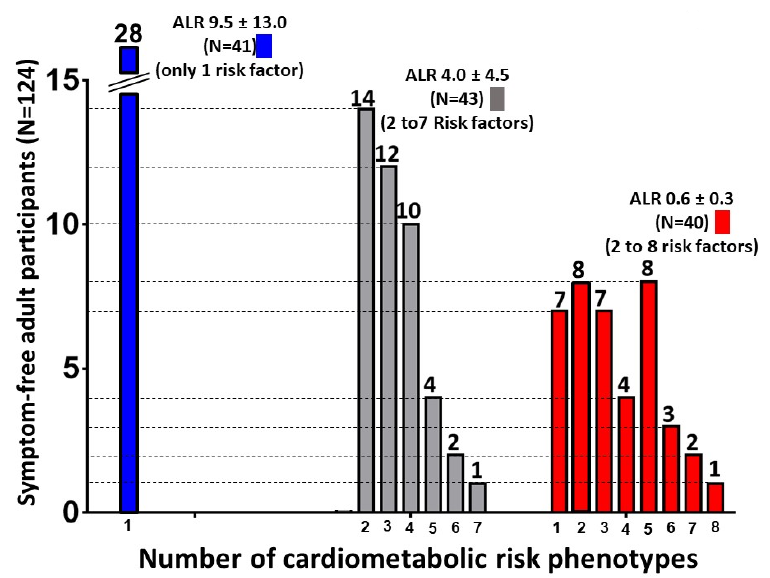
Figure 1. Number of cardiometabolic risk phenotypes among our symptom-free participants (N = 124)